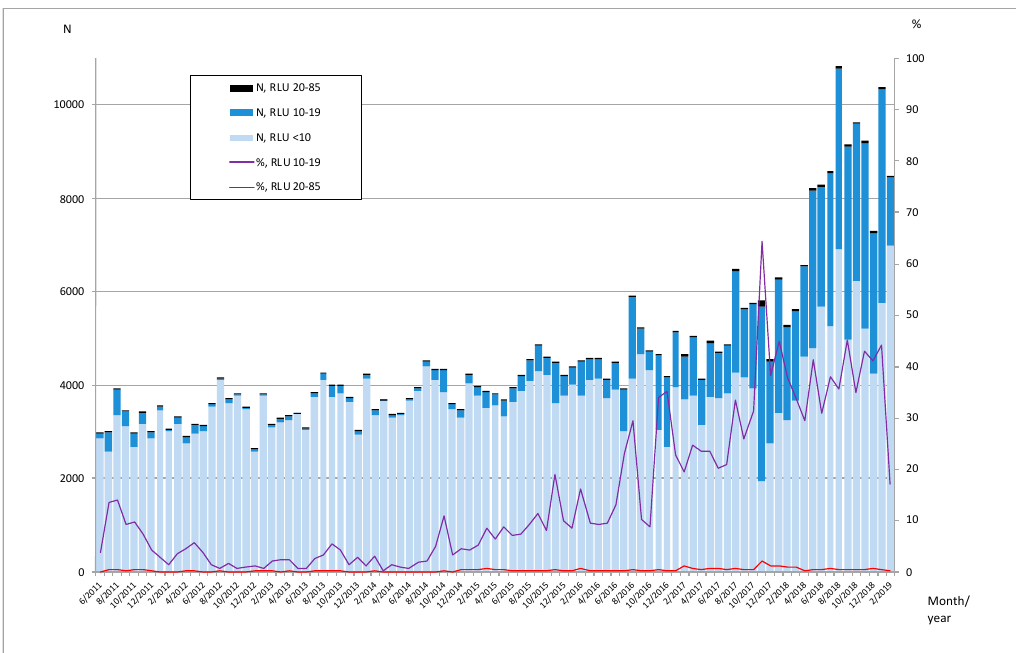
Figure 4. AC2 negative specimens analyzed in the Helsinki University Hospital Laboratory from June 2011 to February 2019 according to their RLU result. Data for this analysis were available from 434,000 specimens. Black bars represent negative specimens yielding an RLU result between 20 and 85; the blue bars represent negative specimens yielding an RLU result between 10 and 19; and the light blue bars represent all other negative specimens (RLU < 10). The red line represents the proportion (%) of specimens yielding an RLU result between 20 and 85, and the purple line represents the proportion (%) of specimens yielding an RLU result between 10 and